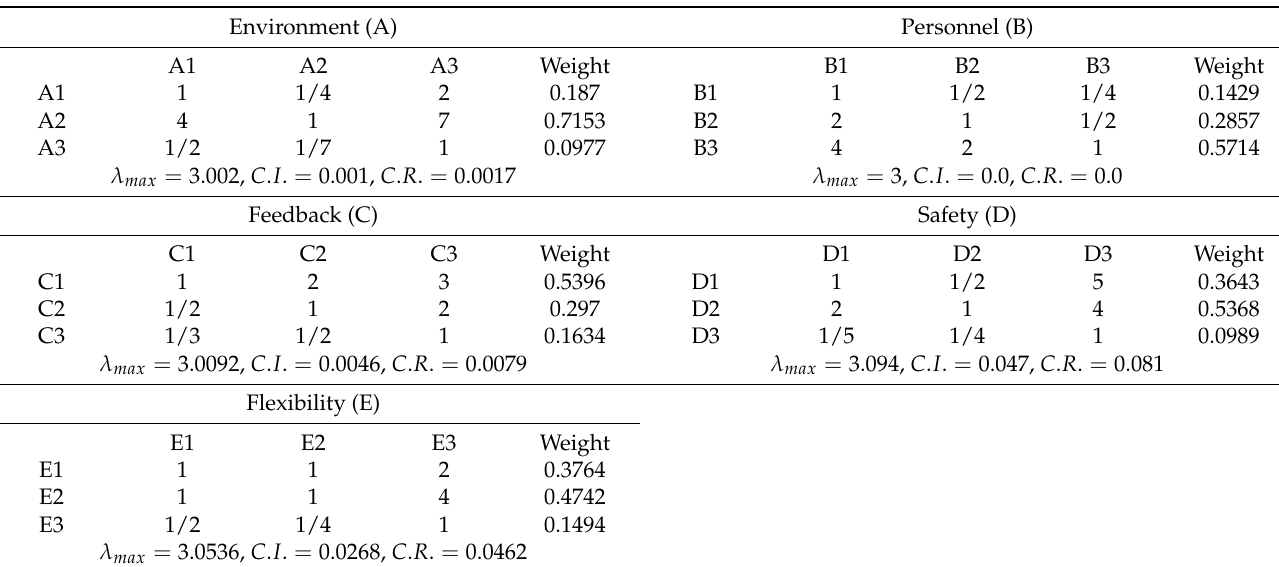
Table 10. The de-fuzzified pairwise comparison matrix for all sub-criteria.